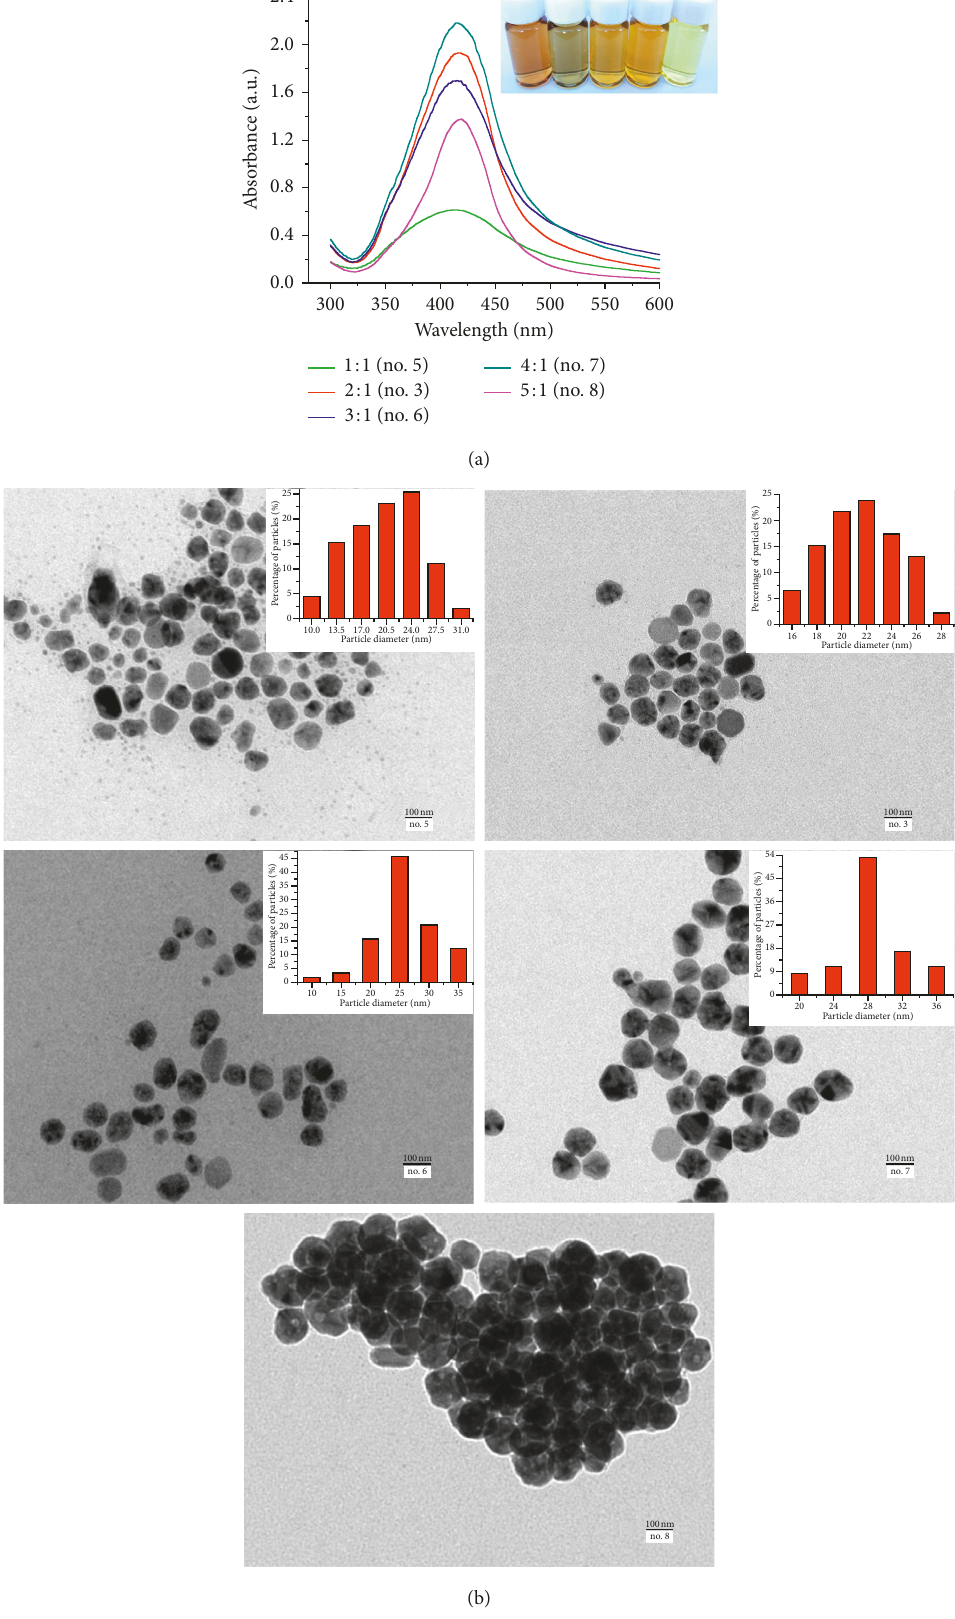
Figure 4: UV-Vis absorption spectra (a) and TEM images (b) of five groups of AgNPs synthesized under different glucose